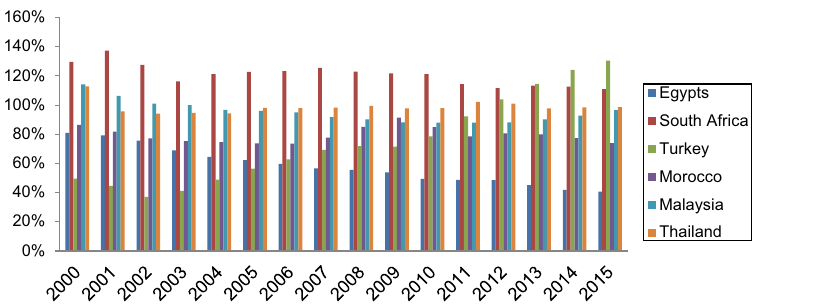
Figure 5. Ratio of loans to